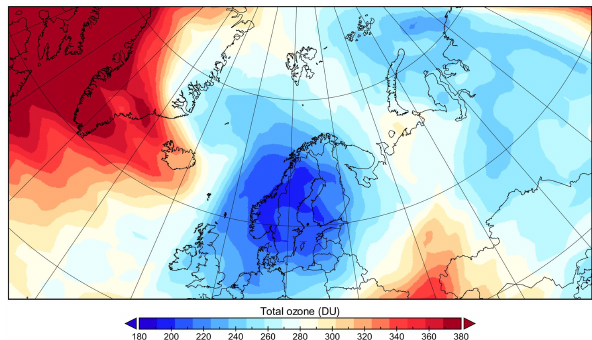
Figure 11. Total ozone column on 4 December 2019 at 12:00UTC from the GOME-2A satellite (data downloaded from http://www.temis.nl/protocols/o3field/o3field_msr2.php, last access 19 May